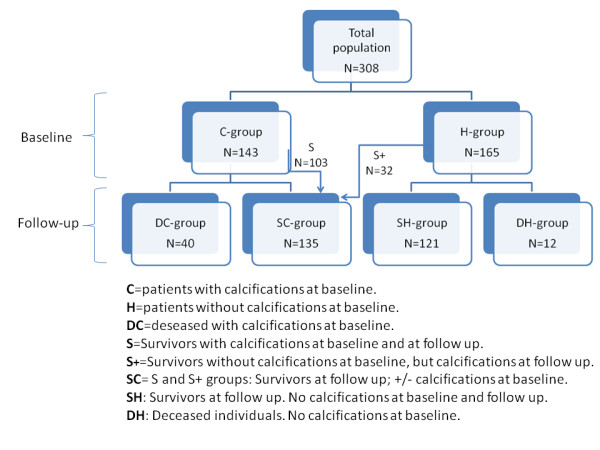
Study population and the sub-populations.